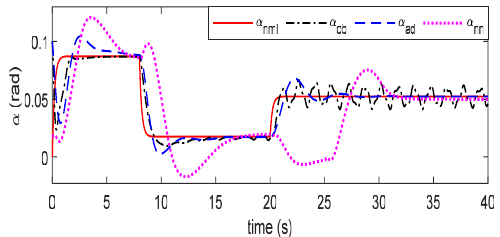
Figure 3. Tracking effects of attack angle α .